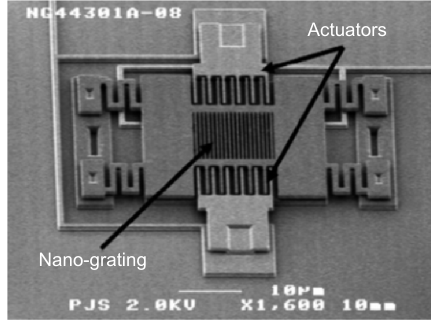
Fig. 26 | SEM of the near-field MOEMS accelerometer based on vertically stacked sub-wavelength nano-gratings. Figure repro- duced with permission from ref. 149 , Elsevier.